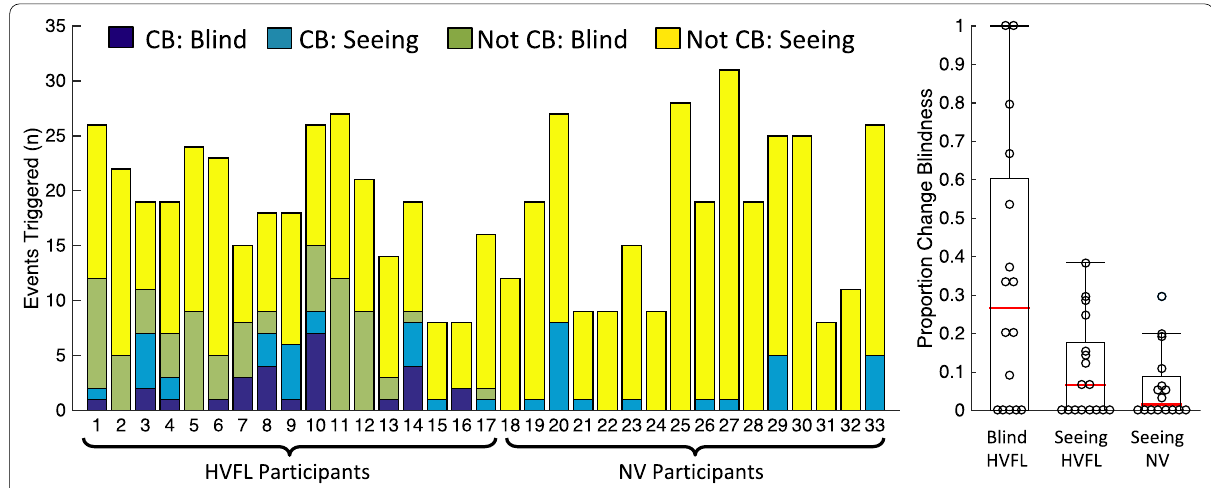
Fig. 5 On the left, each bar represents a different participant with the color corresponding to the number of events per category. On the right, boxplots represent the proportion of change blindness events for HVFL and NV participants based on the hemifield in which the change appeared. Individual markers (open circles) in the figure on the right correspond to the proportion of events that were categorized as change blindness for each participant. CB change blindness, Blind events that appeared in the blind hemifield in those with HVFL, Seeing = = the seeing hemifield of those with HVFL and